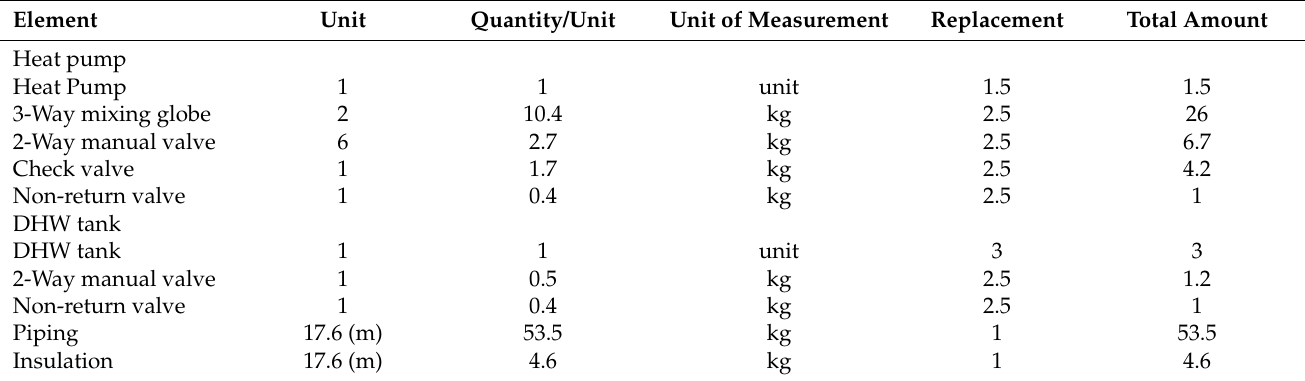
Table 3. Inventory of the reference